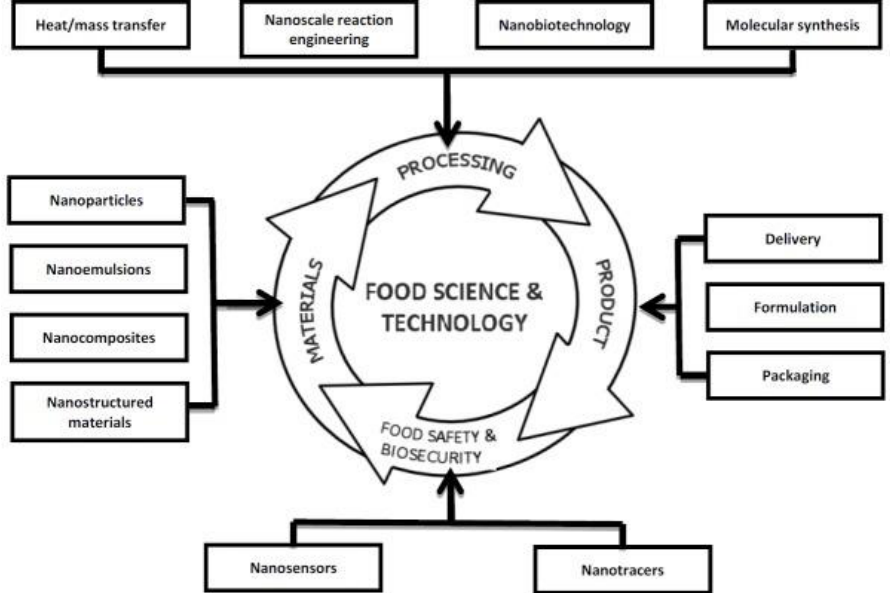
Figure 1. Application matrix of nanotechnology in food science and technology (adapted from